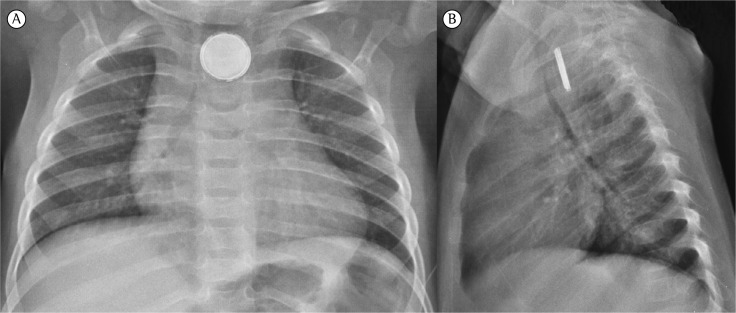
Em A, radiografia de tórax em incidência anteroposterior revelando uma
sombra radiopaca circular com dupla borda periférica ou efeito auréola, e,
em B, radiografia em perfil mostrando uma sombra em declive, o que permitiu
o diagnóstico de bateria botão alojada no esôfago.